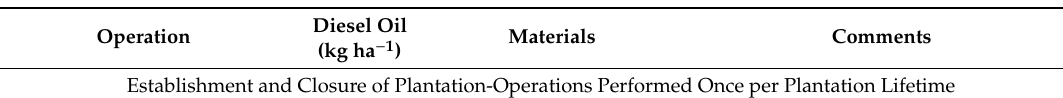
Table 1. Field operations.